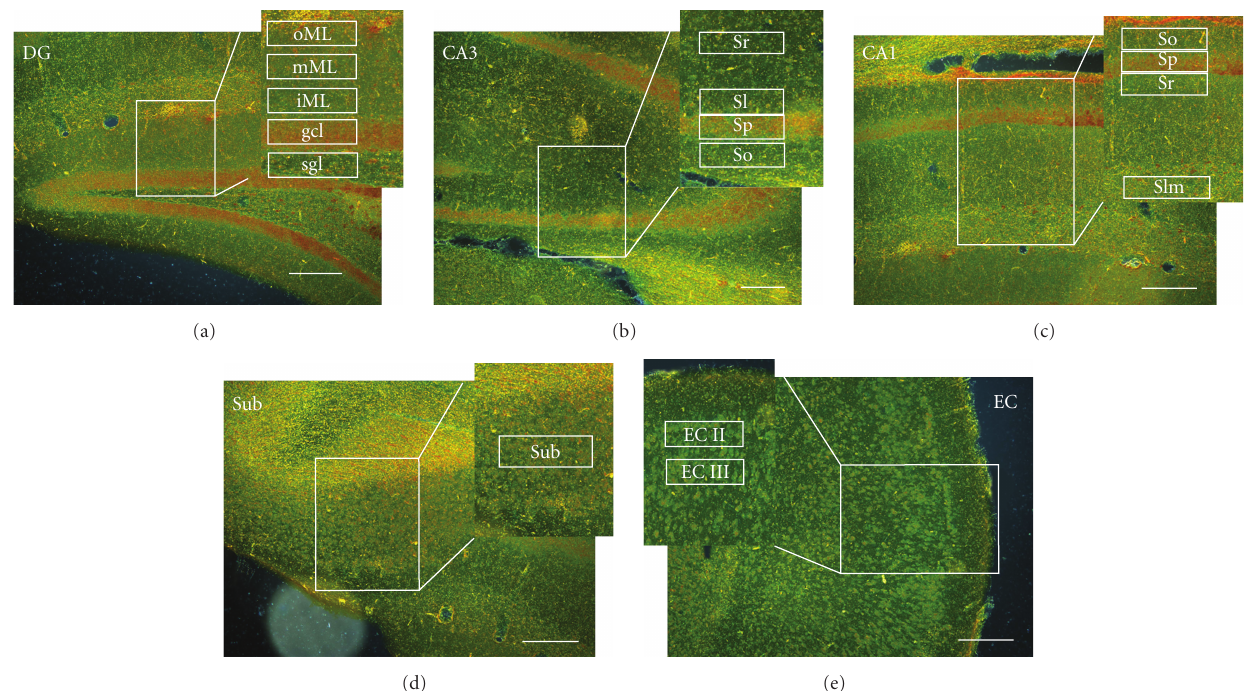
Figure 2: Dark field light microscopy images of the dentate gyrus (DG), CA3, CA1, subiculum (Sub), and entorhinal cortex (EC) with silver- impregnated lysosomal accumulations appearing as bright precipitates (Gallyas technique). In the dentate gyrus, five measuring fields were positioned in the outer (oML), intermediate (mML), and inner molecular layer (iML), as well as in the granule cell (gcl) and subgranular layer of both the suprapyramidal and infrapyramidal blades (not indicated). In CA3, measuring fields were positioned in the stratum radiatum (Sr), stratum lucidum (Sl), stratum pyramidale (Sp), and stratum oriens (So). In CA1, an additional field was set in the stratum lacunosum- moleculare (Slm). One measuring field was positioned in the subiculum and two in the entorhinal cortex in lamina II (EC II) and III (EC III). Scale bar = 200 µ